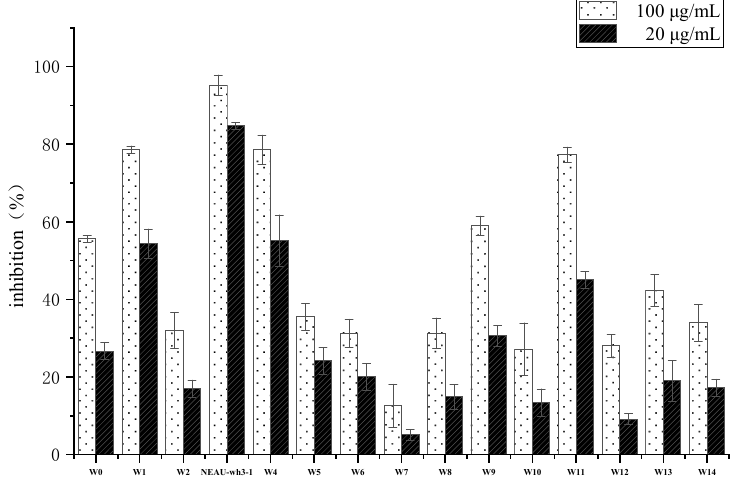
Figure 1. Antitumor activities of extracts obtained from fourteen isolates against human colon tumor cell line HCT-116.